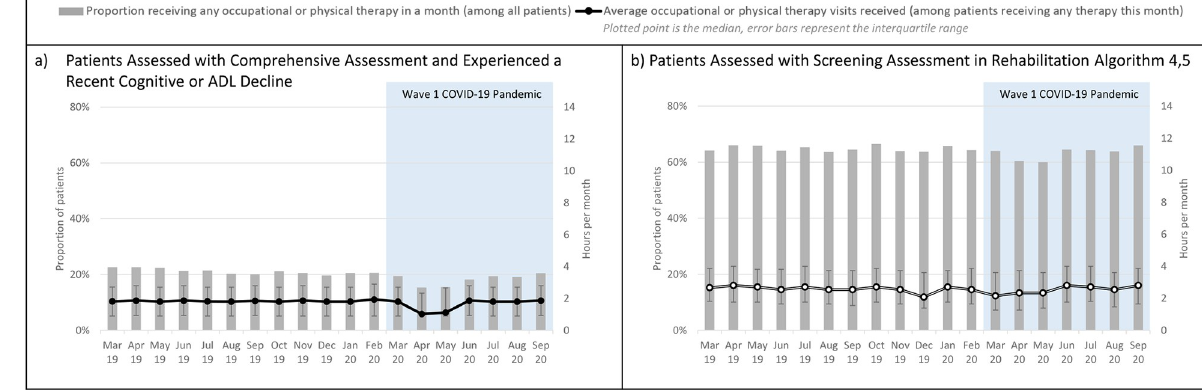
PLOS ONE | https://doi.org/10.1371/journal.pone.0266160 March 30,